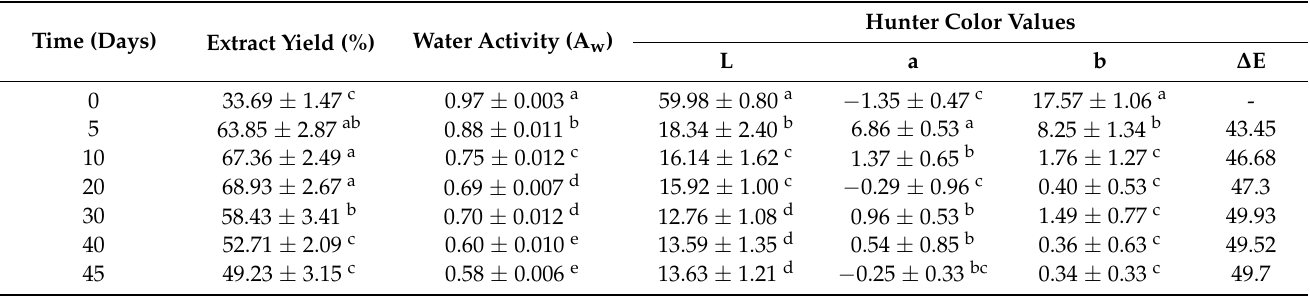
Table 1. Extract yield, water activity, and color of fresh garlic (on day 0) and black garlic obtained from different aging